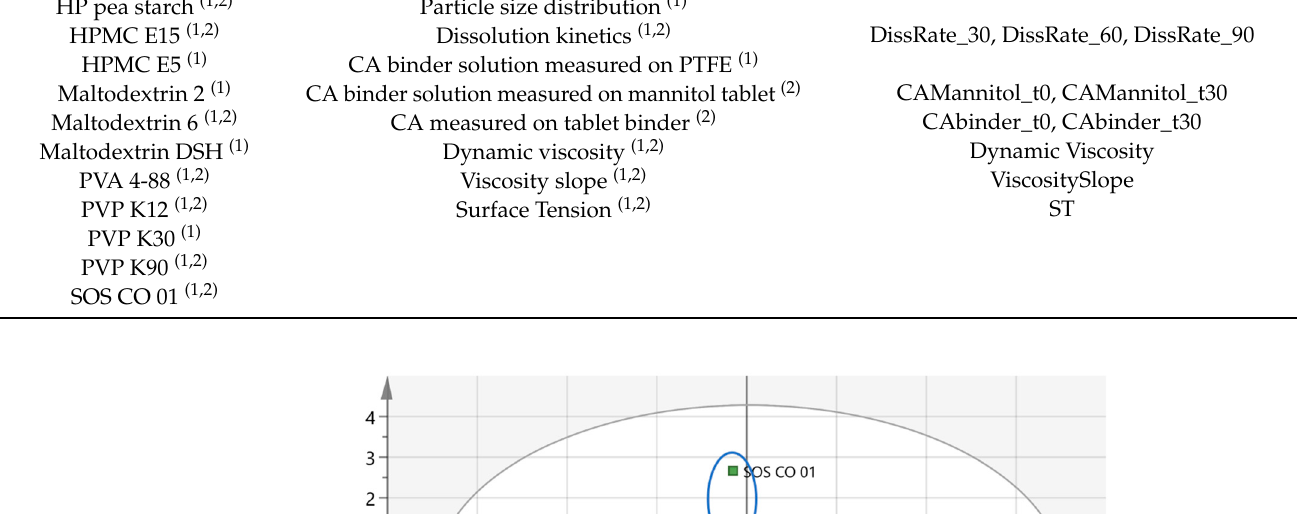
Table 2. Summary of the binders and characterization techniques with corresponding abbreviations used for principal component analysis (PCA). Superscripts (1) and (2) indicate which binders and variables are included in PCA_1 and/or PCA_2, respectively [16]. Characterization Technique